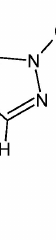
Figure 3. NOE correlation for Z -isomer of compound 41